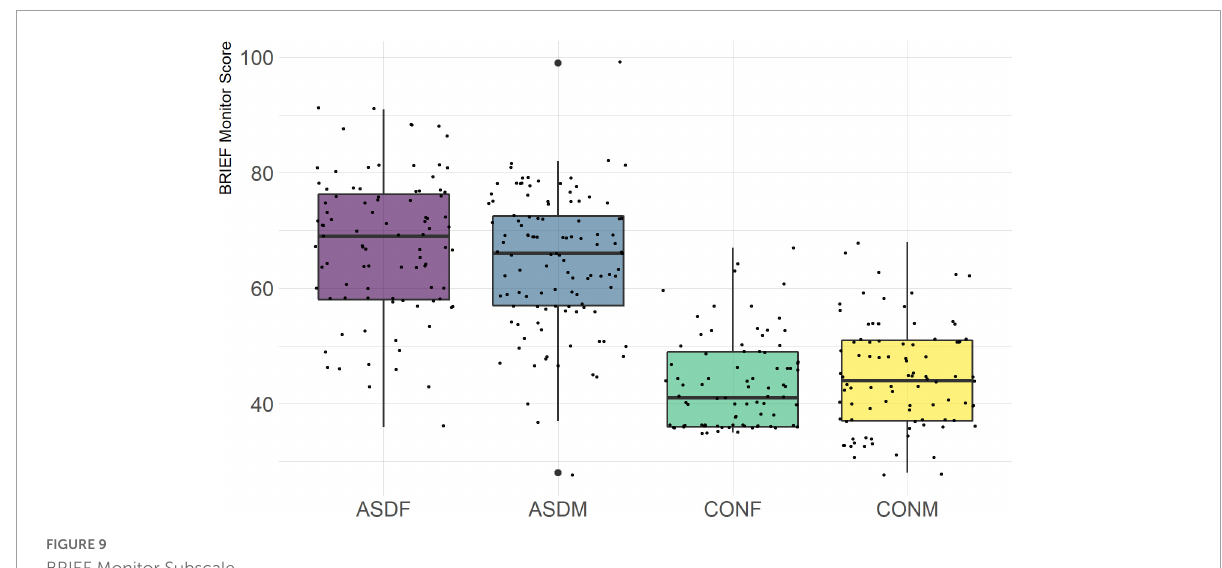
FIGURE9 BRIEF Monitor